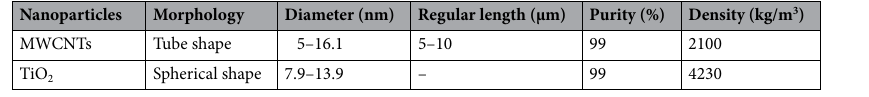
Table 1. Nano additives characteristics.